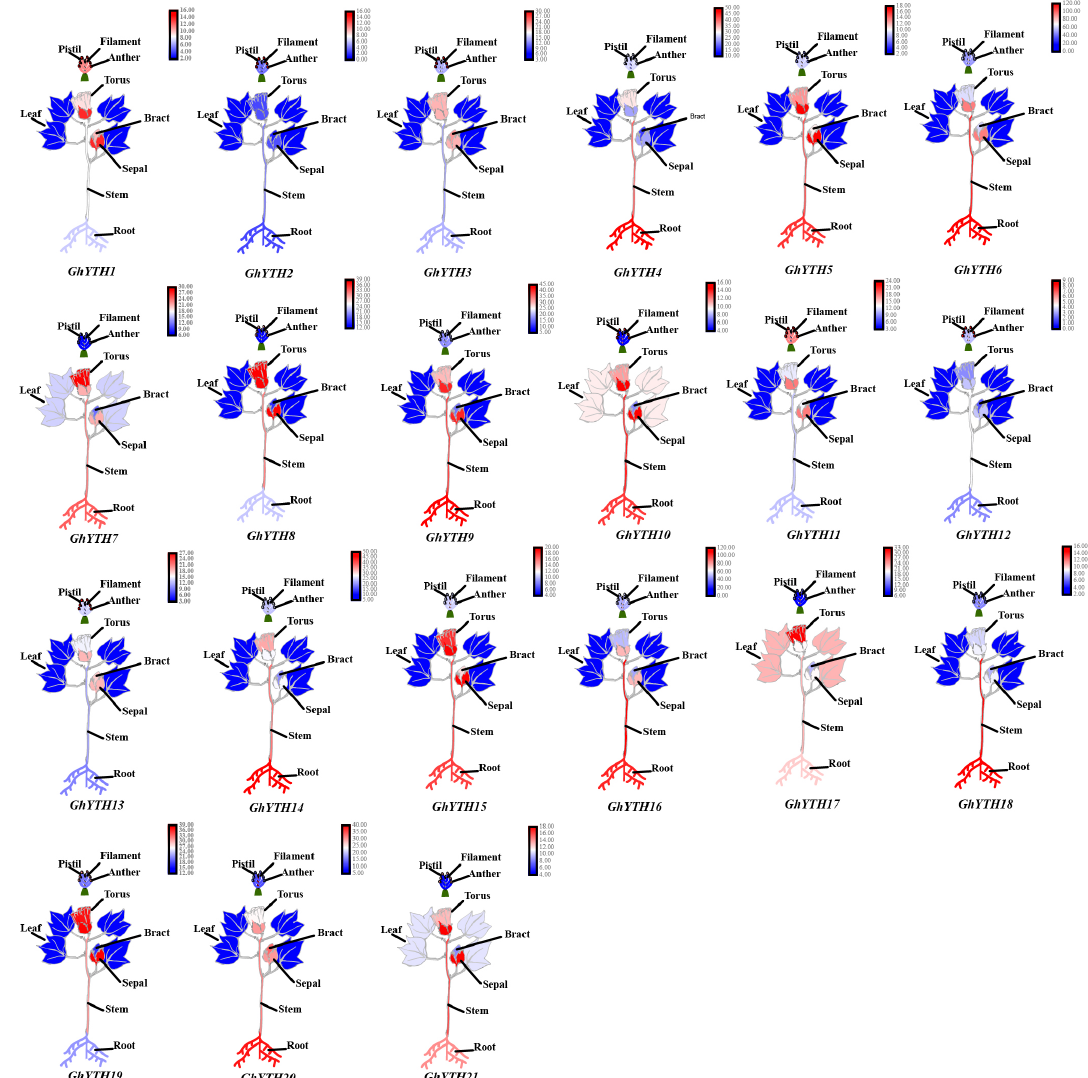
Figure 8. Expression patterns of GhYTHs in different organs (torus, stem, sepal, root, pistil, petal, leaf, filament, bract, and anther).